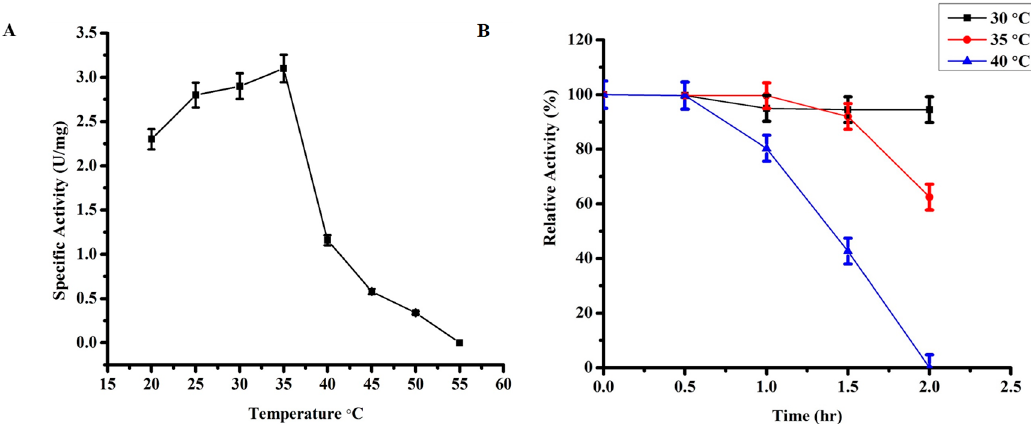
Figure 1. Effect of Temperature and thermostability on phospholipase B activity. ( A ) Optimum temperature of putative phospholipase B was assessed at temperature from 20–55 °C. ( B ) The thermostability of putative phospholipase B was carried out at 30–40 °C. The enzyme was more stable at 30 °C. The activity were assessed after every 30 min and the activity at zero is taken as 100 and is the maximum activity. The error bars shows the mean ±SD of the experiments in triplicate ( n = 3).